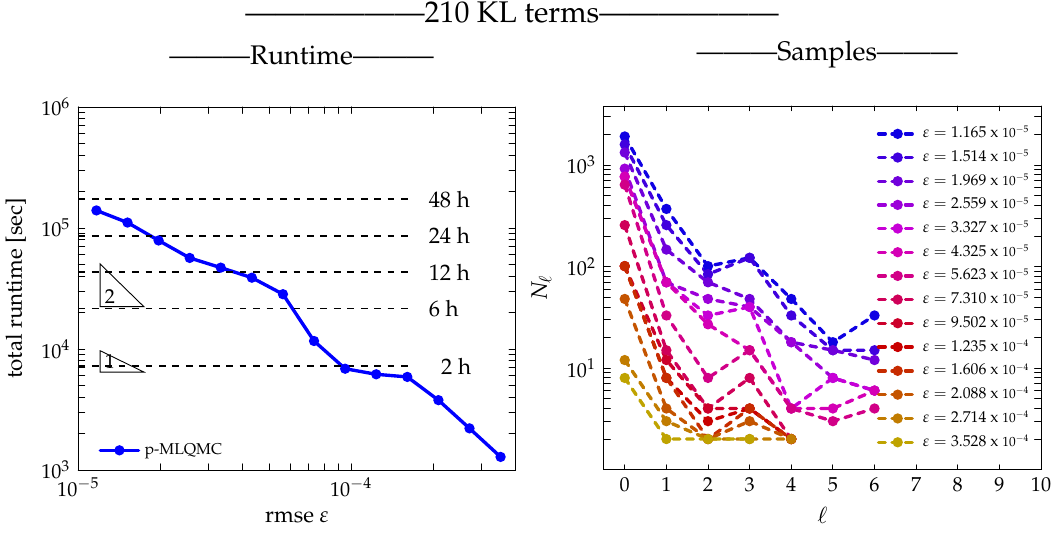
Figure 30. Runtime and sample sizes for a high stochastic dimension for model problem